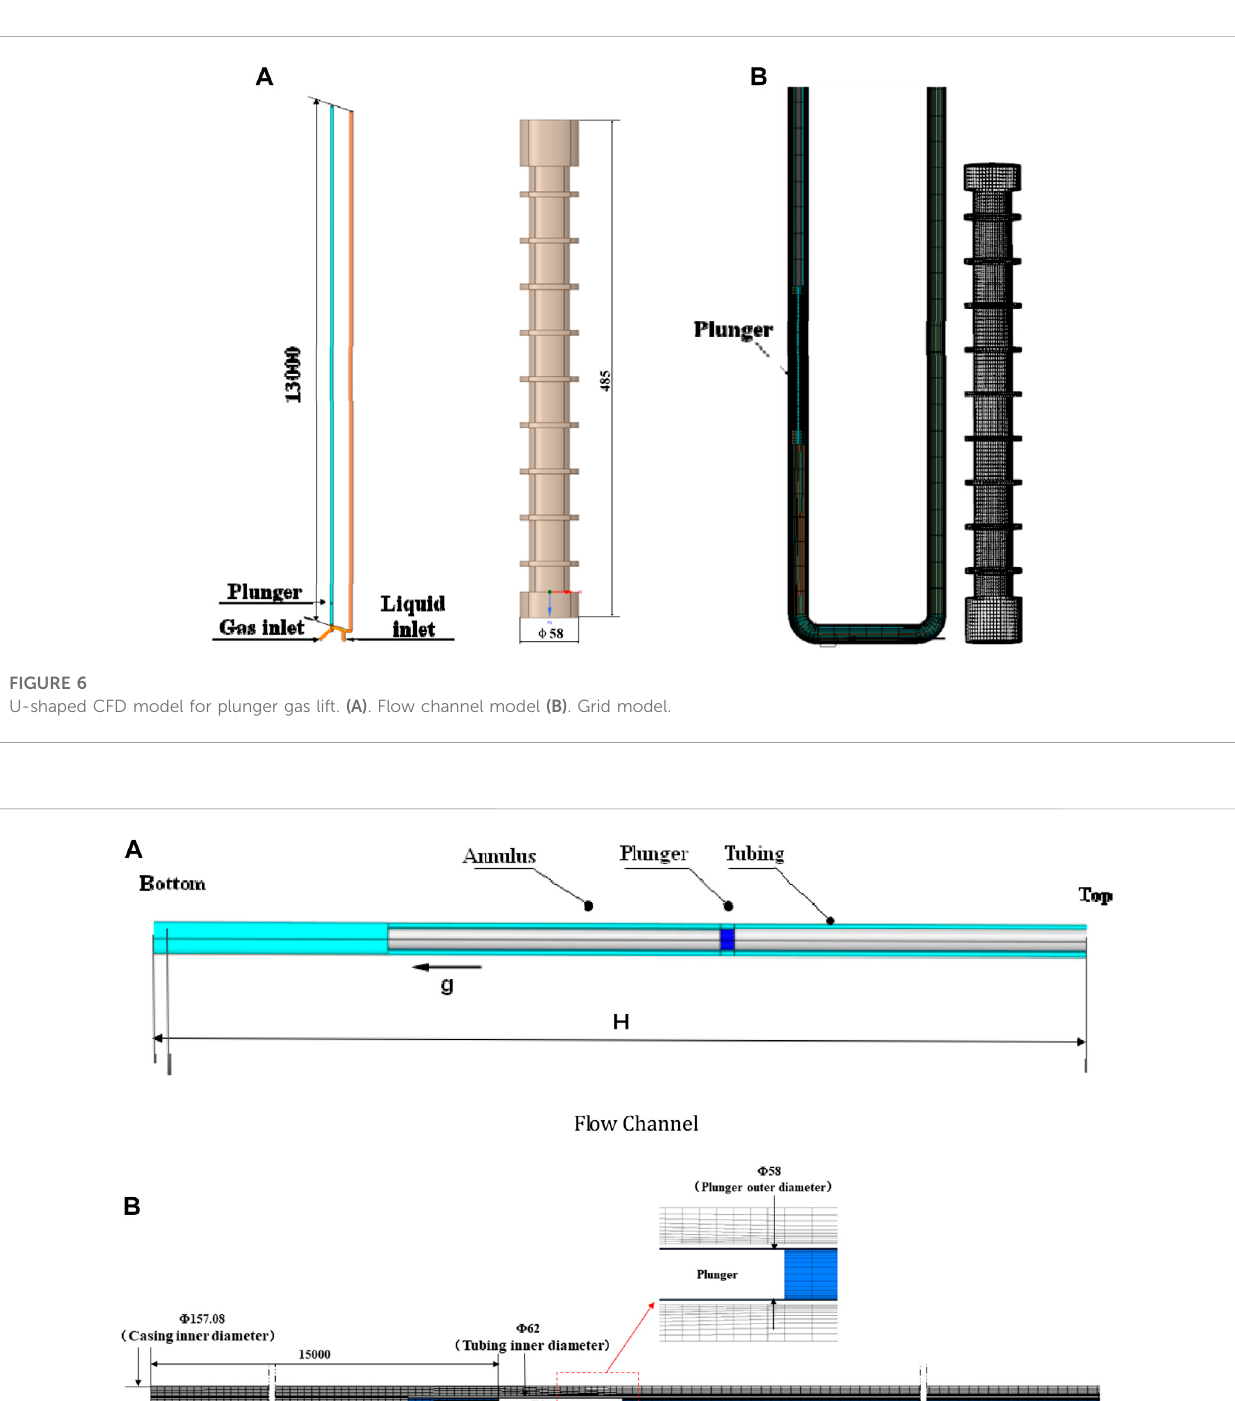
pressure ranges were respectively 20 – 70 ° C and 5 – 30 MPa. The speci fi c parameter values are as shown in Table 2.